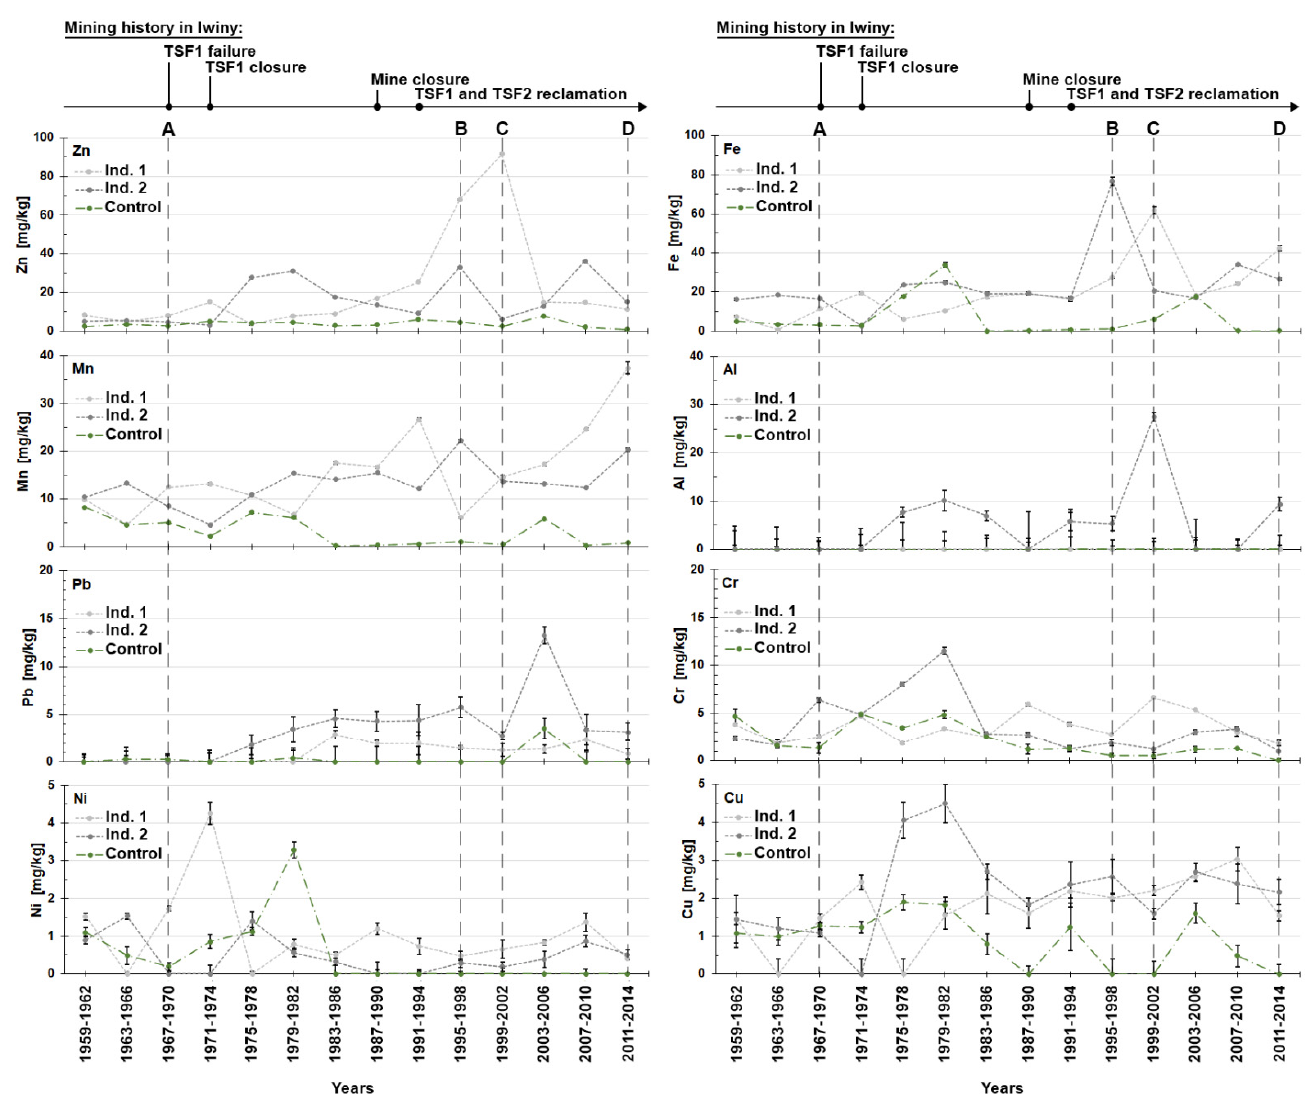
Figure 4. Trace elements (TEs) contents [mg/kg] in tree rings of all studied trees: Industrial 1 (Ind. 1), Industrial 2 (Ind. 2), and Control from 1959 to 2014. Vertical dashed lines indicate the time intervals (A–D) verified by inductively coupled plasma ‐ mass spectrometry (ICP ‐ MS).